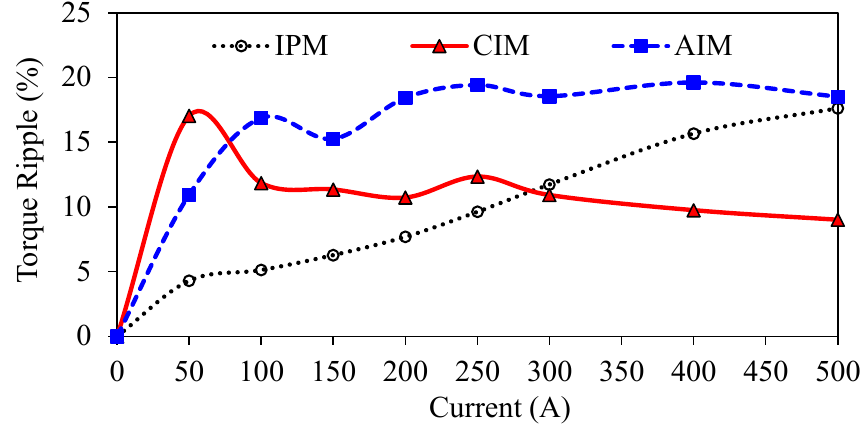
Figure 10. Comparison of torque ripple percentage for different electric loadings.